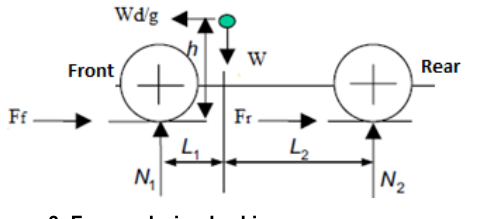
Figure 3. Forces during braking. N and N are the normal forces acting on the front and 1 2 rear wheels,